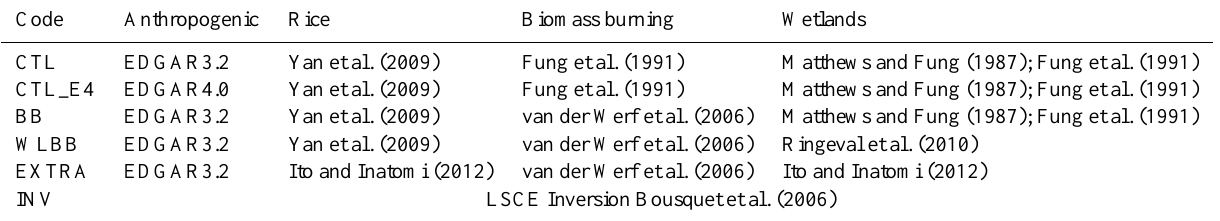
Table 1. The broad components of the methane emission scenarios. The anthropogenic category includes fossil fuel, industrial, animal, fire, waste and biofuel emissions. See Patra et al. (2011) for further details of how the emission scenarios were constructed.